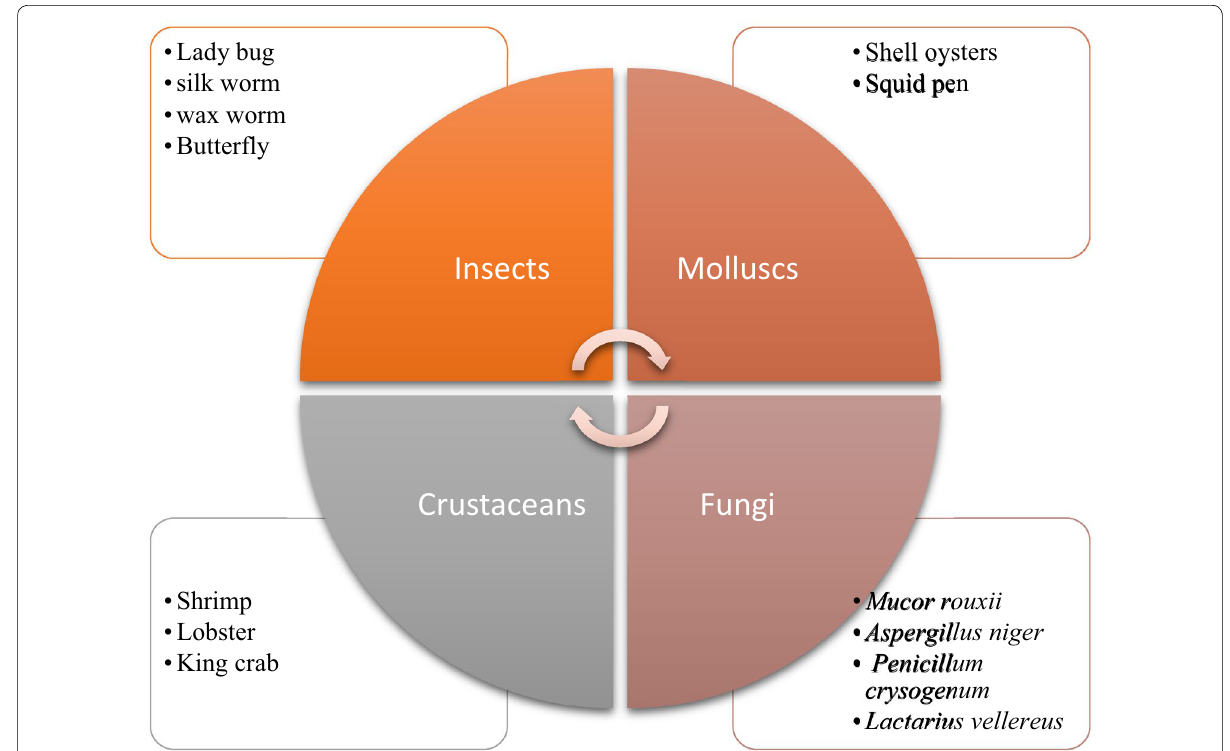
Fig. 1 Sources of chitin